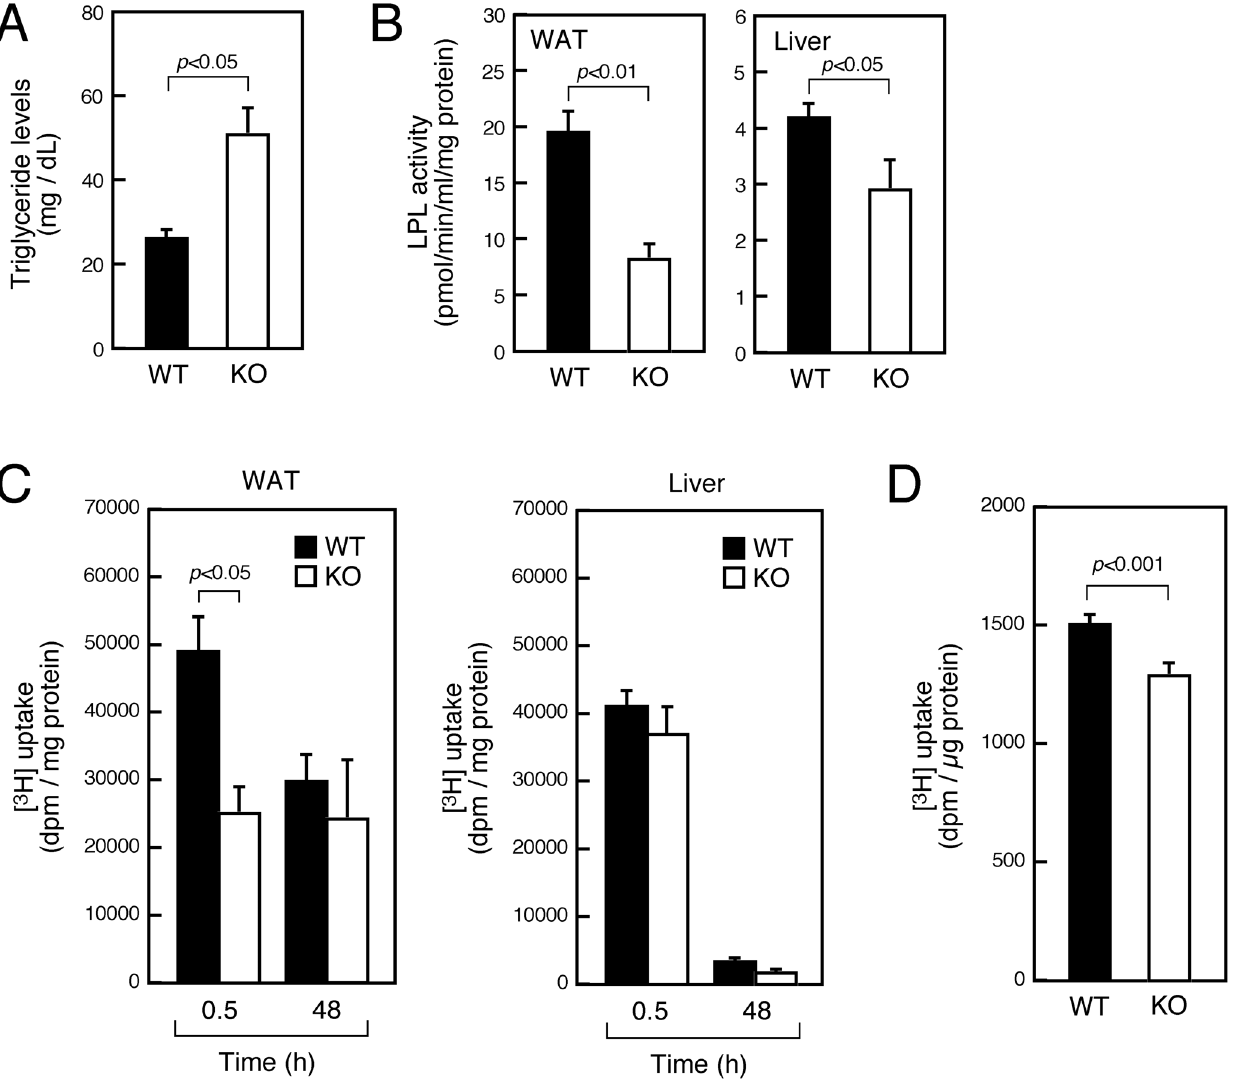
Figure 2. LPL activity and fatty acid uptake are reduced in WAT of SMS1-KO mice. (A) Shown are triglyceride levels in blood plasma of 14- week-old mice (WT, n =3; KO, n =3). (B) LPL activity was assayed in WAT and liver of 20-week-old mice (WT, n =6; KO, n =5). (C) [ 3 H]palmitic acid was intraperitoneally injected to 4 h-starved mice. After 0.5 h (WT, n =8; KO, n =5) or 48 h (WT, n =7; KO, n =3), tissues were isolated and radioactivity in tissues was measured. (D) Assessment of [ 3 H]palmitic acid uptake into MEFs isolated from wild-type (WT, n =30) and SMS1-deficient (KO, n =30) embryos.